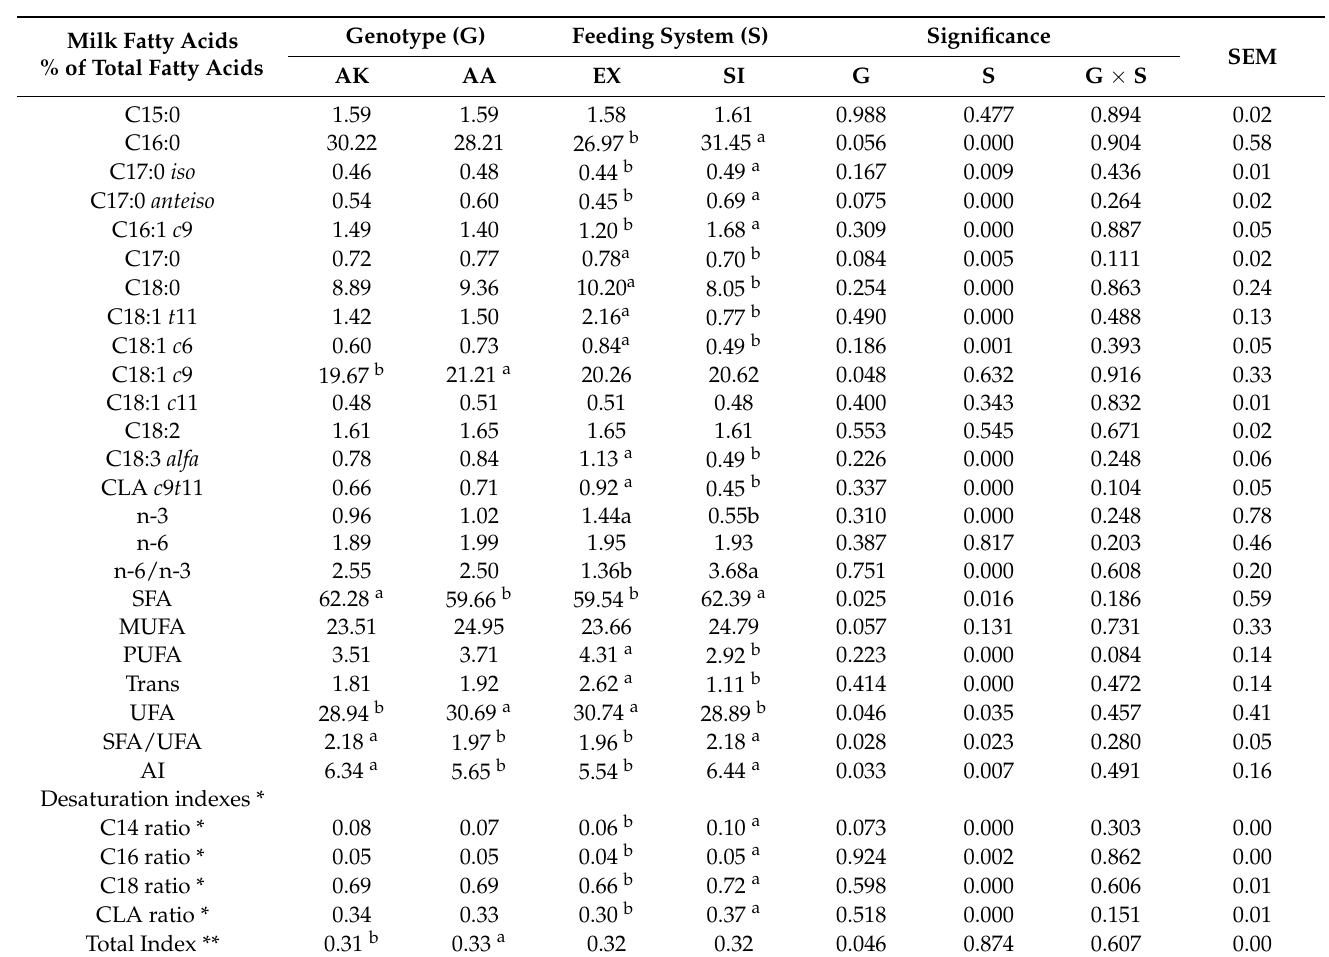
C4:0, C6:0, C8:0, C10:0 (Figure 2): in particular, within the EX system, the AA cows